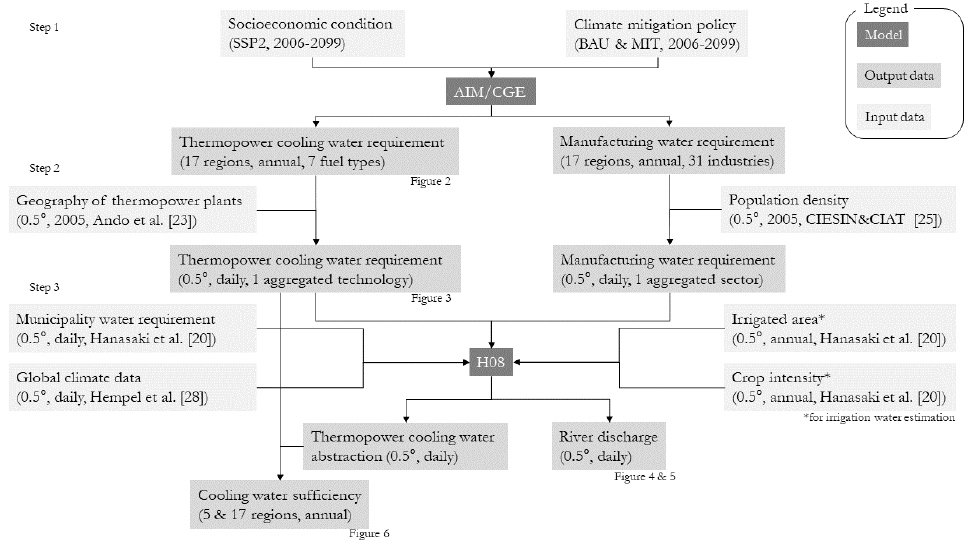
Figure 1. Schematic diagram of data flow. SSP, BAU, and MIT stand for Shared Socioeconomic Pathways, business as usual, and mitigation,